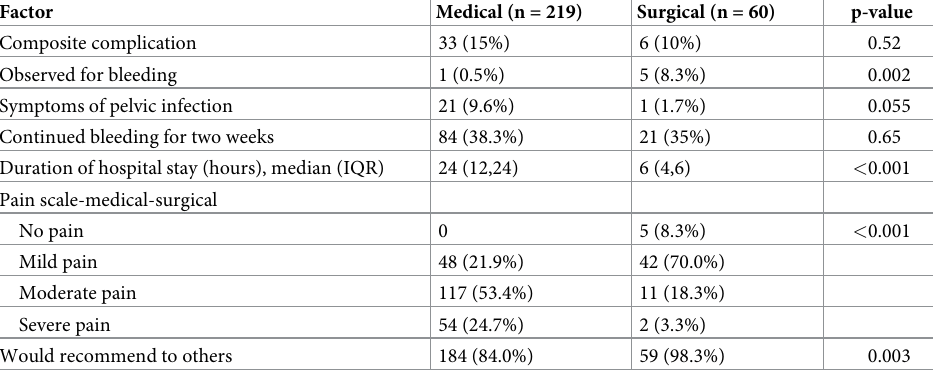
Table 3. Procedure details and complications of study participants. Factor Medical (n =